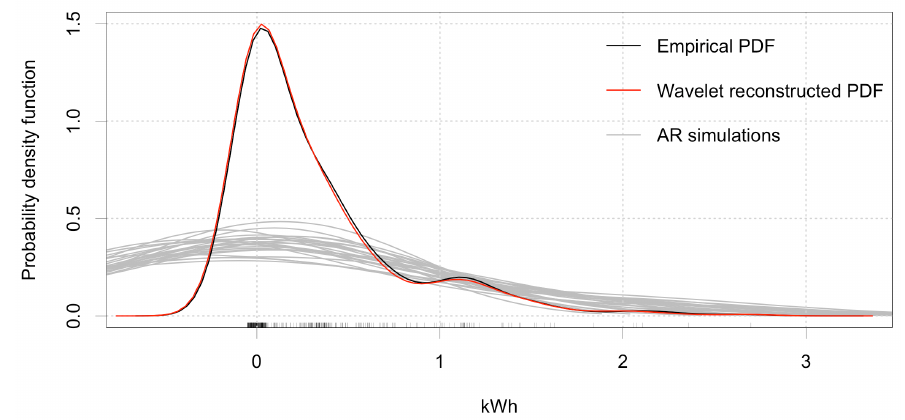
Figure 12. Simulation of the wavelet decomposed 5 a.m. hourly energy usage by DHW heater in RBSA home 13088 from Q2 2012–Q1 2013 inclusive, using the Autoregressive